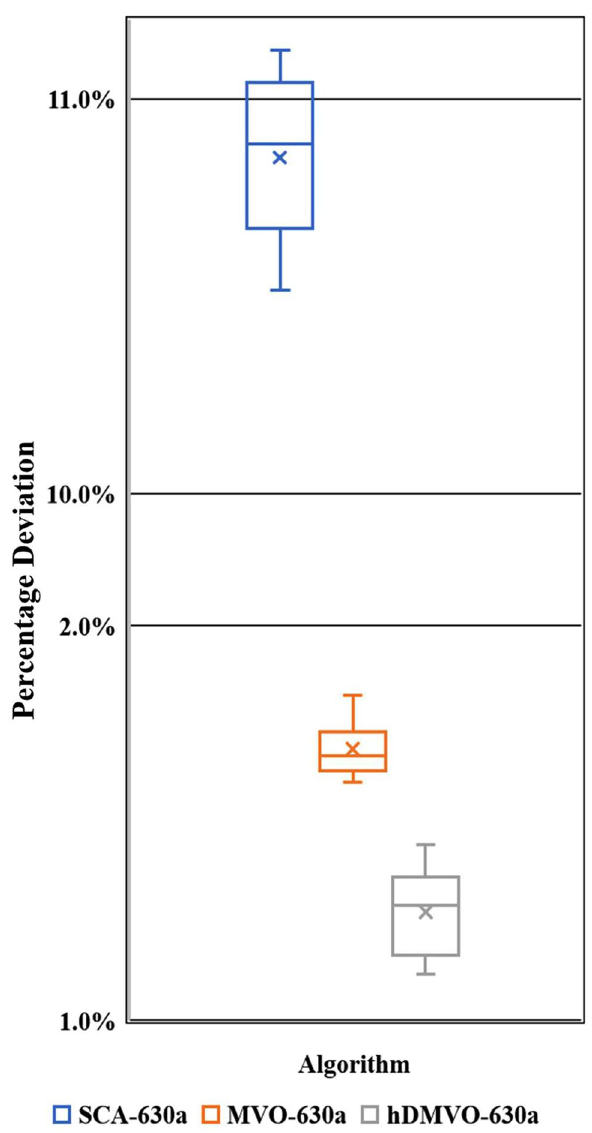
Figure 13. Percentage deviations of hDMVO, MVO and SCA in problem